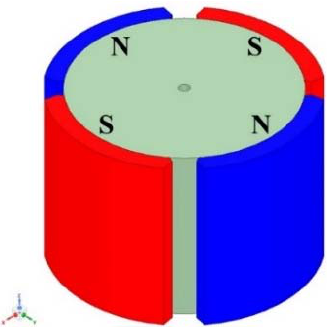
Figure 5. Model of surface permanent magnets and the rotor.